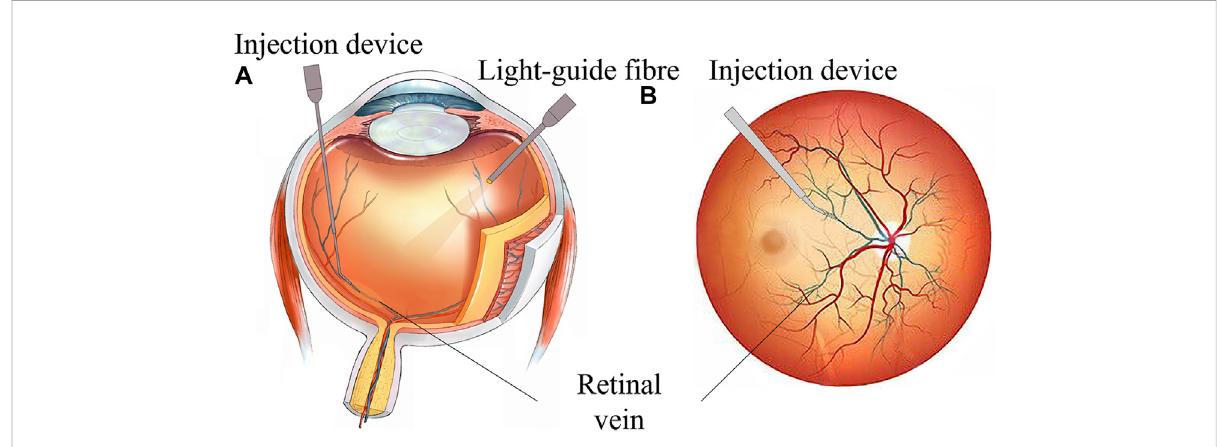
FIGURE 1 RVC surgical manipulation. (A) Coronal plane of the eyeball. (B) Transverse plane of eyeball